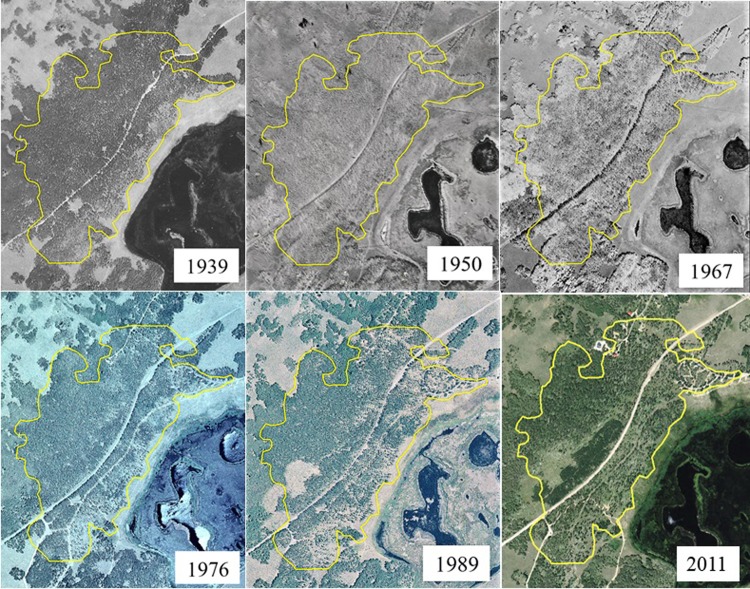
A seventy-two year aerial photo chronosequence showing forest cover change within the Pando aspen clone, Utah, USA.Photos were georectified using ArcMap® software to ensure accurate scale and location alignment. Yellow polygon depicts the boundary of the 43 ha clone as projected over each photo year. Base image courtesy of USDA Aerial Photography Field Office.